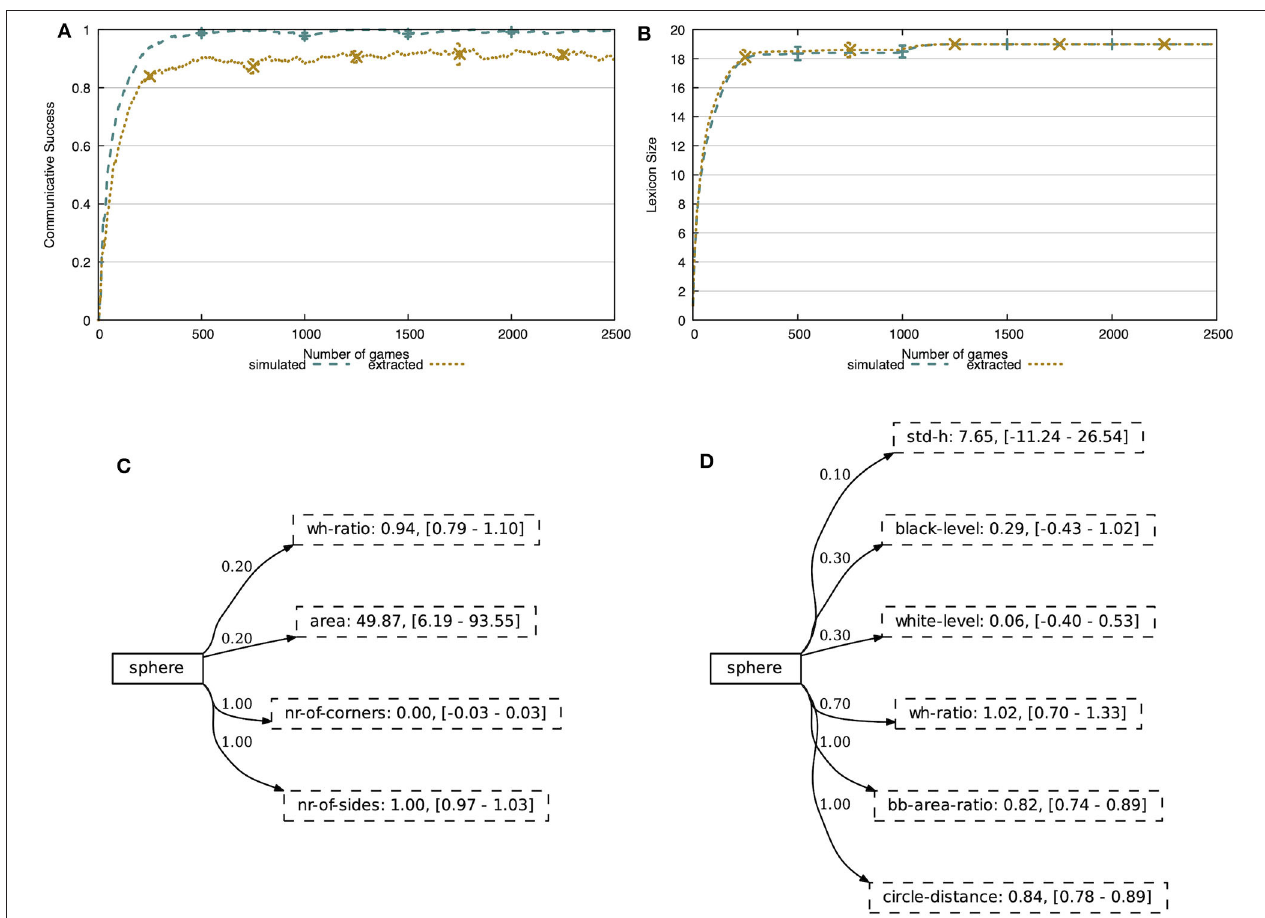
FIGURE 7 | (A) The communicative success rises quickly and achieves 100% in the simulated world and 91% in the noisy world. (B) In both environments, the agent acquires exactly 19 concepts. The concepts are human-interpretable and capture discriminative combinations of attributes. The concept SPHERE focusses on attributes related to shape, both in the simulated environment (C) and the extracted environment (D) . Attributes with certainty score 0 are